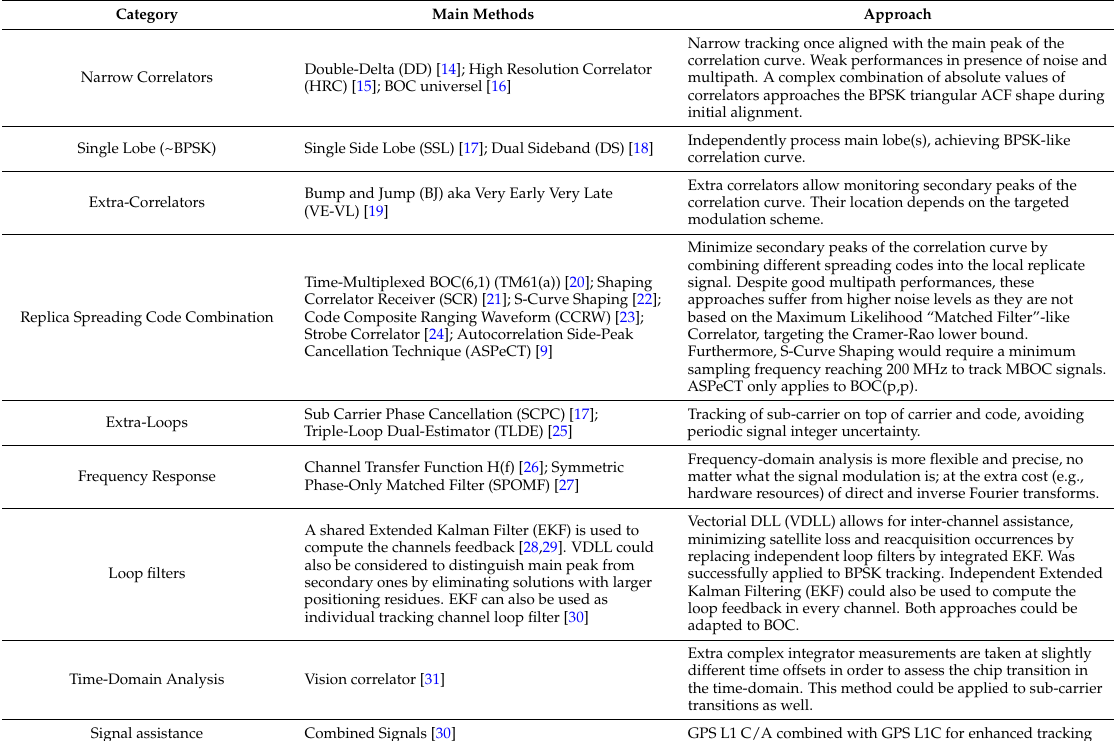
Table 2. BOC Tracking Channel Architectures